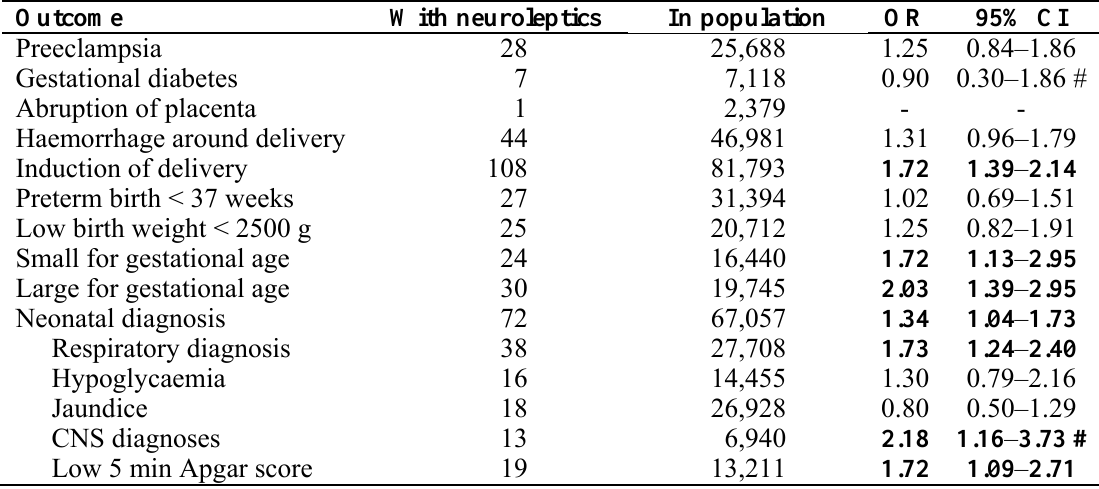
Table 22. Outcomes after maternal use of neuroleptics with the exception of dixyrazine and prochloperazine during the 2nd or 3rd trimester. Bold text marks statistical